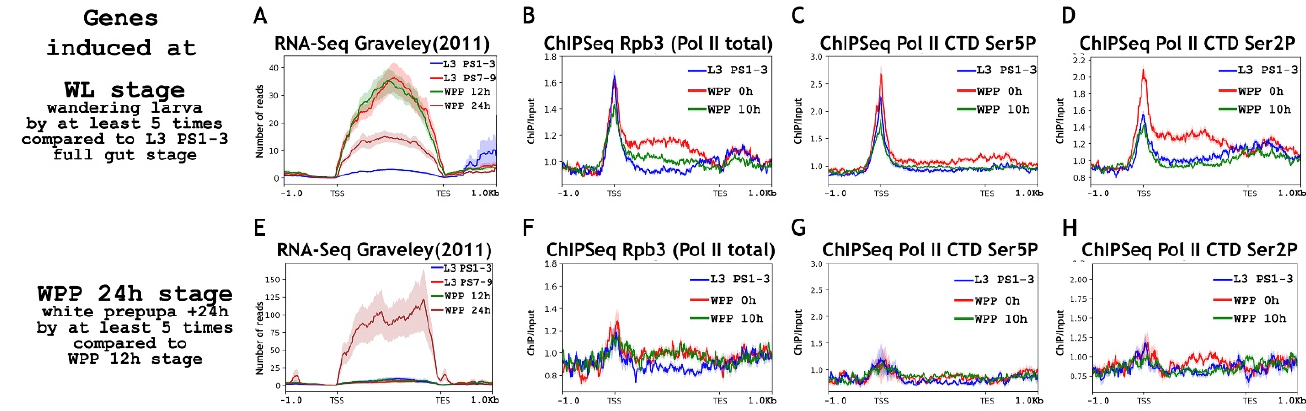
Figure 5. Average binding profiles of various Pol II isoforms on genes induced during Drosophila puparium formation (WL: wandering larva) and 24 h after puparium formation (WPP 24 h: white prepupa 24 h). Average of the ( A ) RNA-seq signal and an average distribution of ( B ) Rpb3 (Pol II subunit), ( C ) Pol II Ser5P CTD, and ( D ) Pol II Ser2P CTD binding across the genes induced in wandering larvae L3 (WL stage: wandering larva) (total 303 genes/852 transcripts). Average of the ( E ) RNA-seq signal and an average distribution of ( F ) Rpb3 (Pol II subunit), ( G ) Pol II Ser5P CTD, and ( H ) Pol II Ser2P CTD binding across the genes induced 24 h after puparium formation (WPP 24 h stage: white prepupa +24 h) (total 62 genes/108 transcripts). Pools of “WL genes” and “WPP 24 h genes” were selected according to the common rule, to be induced at least five times compared with “L3 PS1-3 full gut” and “WPP 12 h APF” stages, respectively. ChIP-Seqs were performed on the material of whole larvae of L3 PS1-3 full gut stage (blue line), prepupae 0 h after puparium formation (WPP, red line) and prepupae 10 h after puparium formation (WPP 10 h, green line). Protein binding levels were calculated as an enrichment (ratio of the corresponding ChIP-Seq signal to the input DNA). Average profiles were generated using the metagene mode (introns were ignored and gene bodies were scaled to 2 kb) and calculated as the median of the protein binding signal. Average profiles of the RNA-seq signal were calculated as the mean level. The standard error appears on the graphs as a lighter area around the main line of the profiles. Abbreviations: L3 PS1-3: full gut stage of larva L3; L3 PS7-9: empty gut stage of larva L3; WPP 0 h: white prepupa; WPP 10 h, 12 h, and 24 h: prepupa 10 h, 12 h and 24 h after puparium formation, respectively; TSS: transcription start site; TES: transcription end